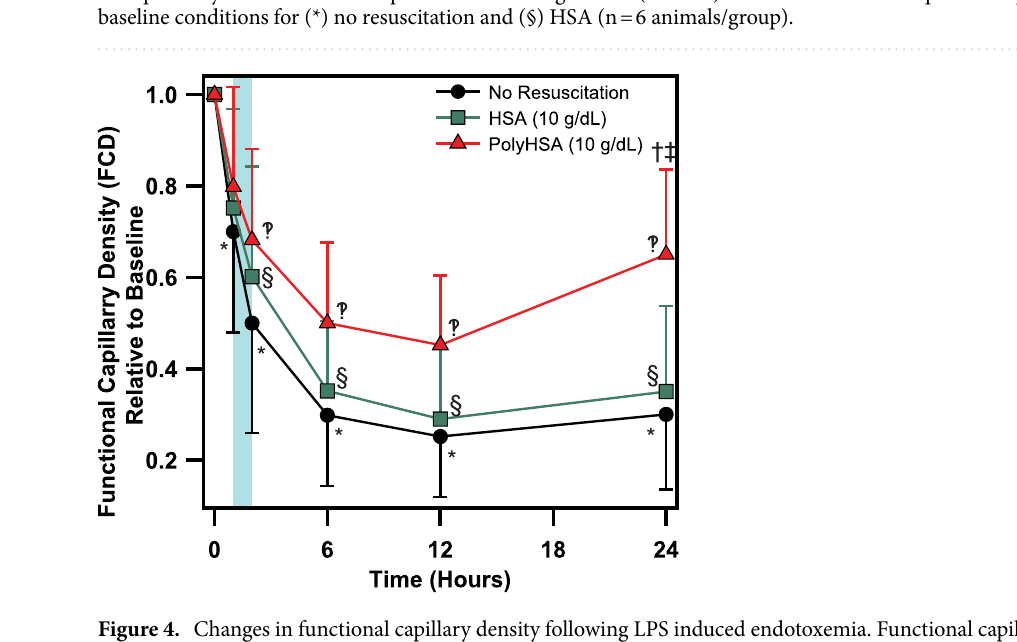
Figure 4. Changes in functional capillary density following LPS induced endotoxemia. Functional capillary density (FCD) with no resuscitation, infusion of HSA, or infusion of PolyHSA. The shaded blue region on the plots indicates the period of fluid resuscitation with PolyHSA or HSA. Data are presented as mean and SD. † P < 0.05 between the PolyHSA and no resuscitation groups at the same time point. ‡ P < 0.05 between the PolyHSA and HSA groups at the same time point. Symbols next to data points indicate a significant (P < 0.05) difference at that time point compared to baseline conditions for (*) no resuscitation, (§) HSA, and ( ‽ ) PolyHSA (n = 6